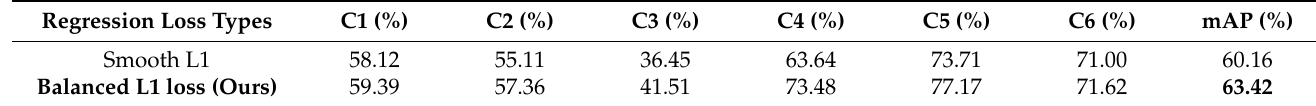
Table 8. Different types of regression